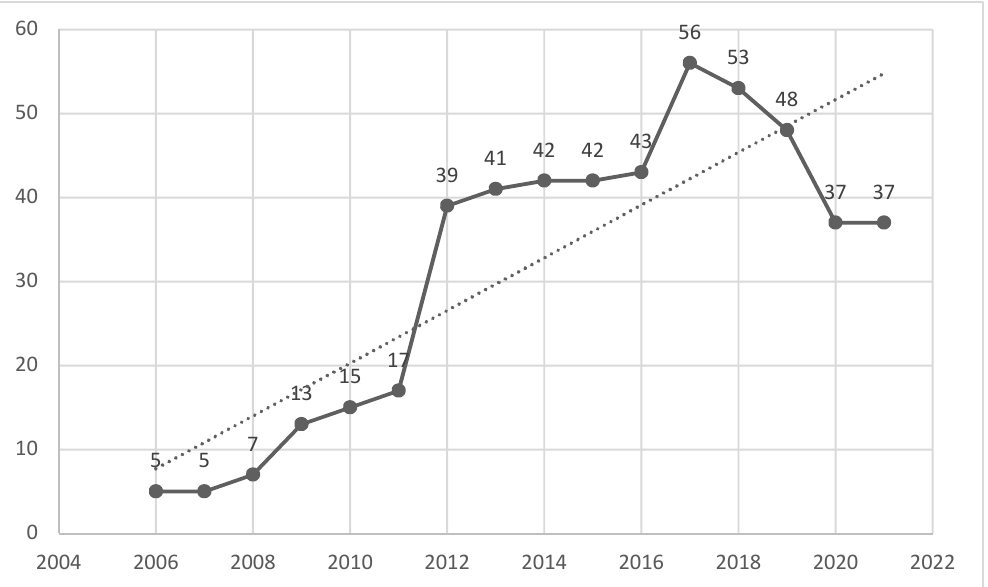
Figure 2. Annual publication trend of Jurnal Pengurusan (2006–2021). Linear regression formula; Y = a + bX ; Y is the cites score and X is the year. Source: authors’